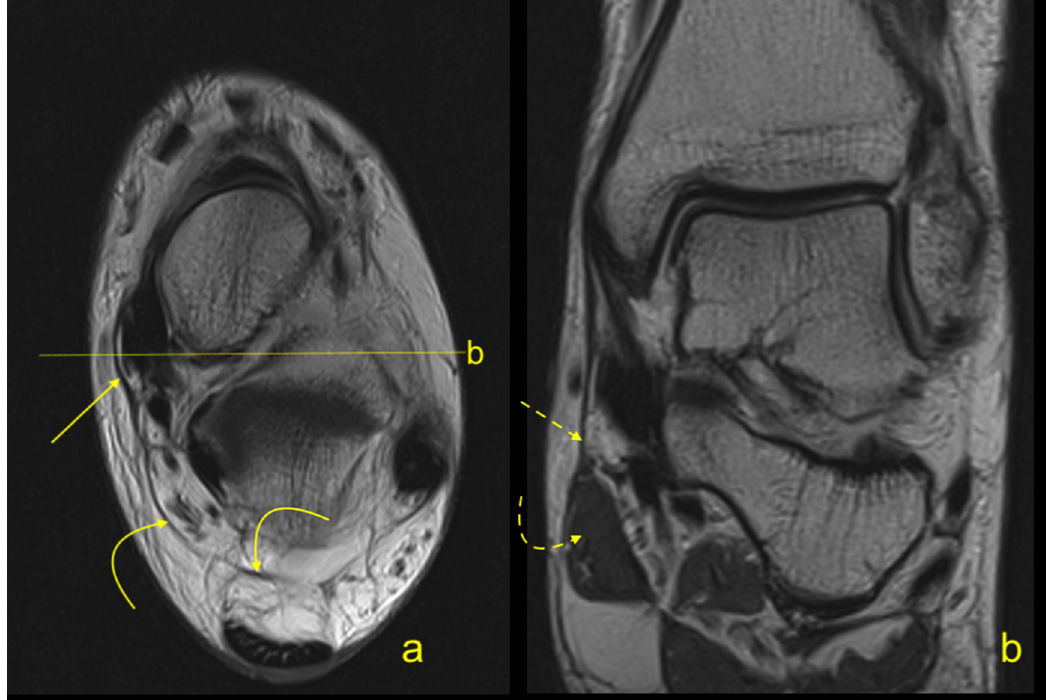
Figure 5. A 32-year-old patient with clinical suspicion of a lipomatous tumor in the lateral side of the ankle. ( a , b )—PD weighted sequences. FR (straight arrow) communicates with the FTCL (curved arrow) in the Kager’s fat pad. The projection (dashed arrow) from FR to abductor hallucis (AbH) (curved arrow) can be identified inferior from the medial malleolus.